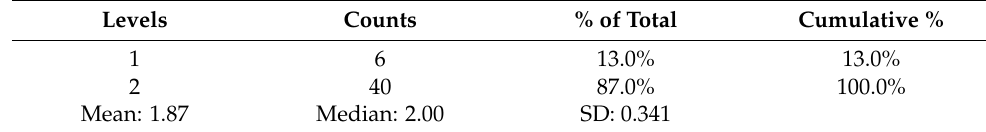
Table 4. “Year of Publication” Score.